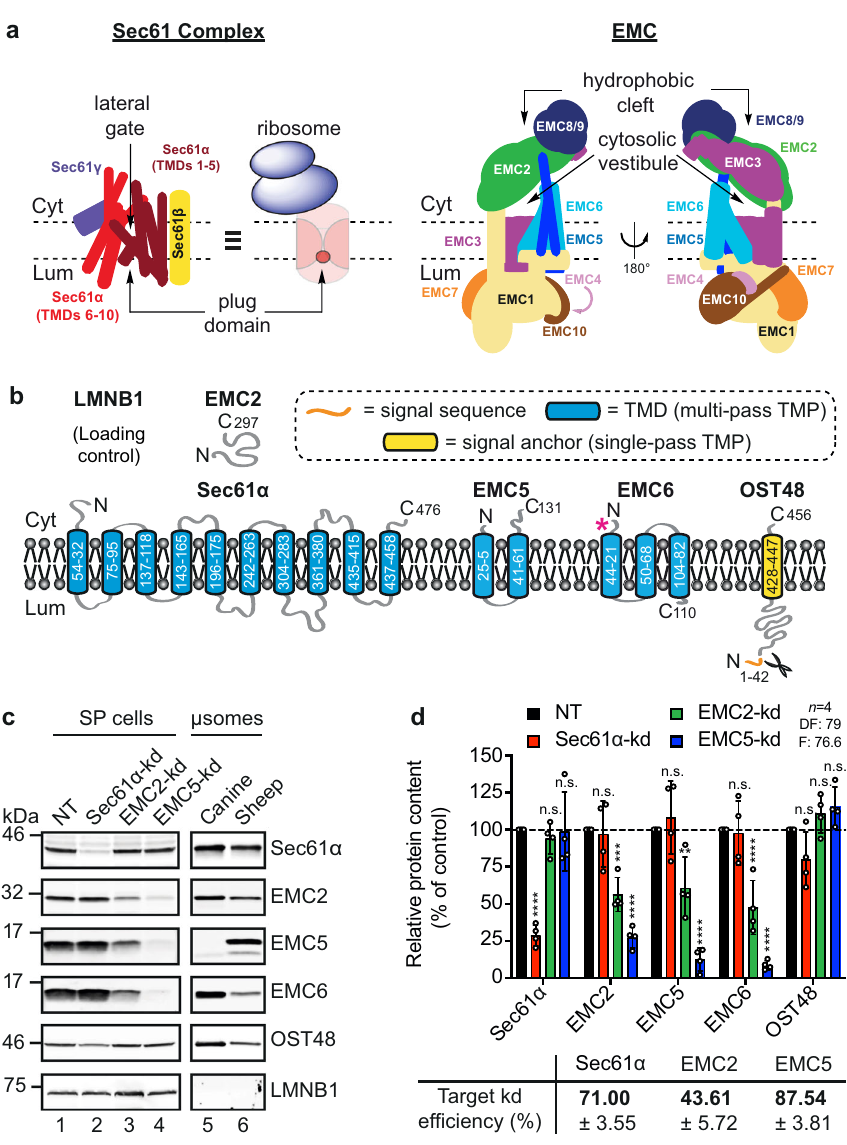
Fig. 2 siRNA-mediated knock-down of Sec61 α , EMC2 and EMC5. a Schematics of the Sec61 complex and the EMC. The heterotrimeric Sec61 complex ( α , β , γ subunits) forms a protein-conducting aqueous channel through which polypeptides are translocated into and across the ER membrane. Its actions are regulated via a plug domain and lateral gate 31,32 . The EMC is organised into a basket-shaped cytosolic domain (EMC2, EMC8/9), a transmembrane- spanning region (EMC3, EMC5, EMC6) and an L-shaped lumenal region (EMC1, EMC4, EMC7, EMC10). The insertase site is formed by EMC3/EMC6 near the cytosolic vestibule, whilst the hydrophobic cleft may have a role in client transmembrane domain capture 11 – 14 . b Outlines of targets for siRNA-mediated knock-down: Sec61 α , EMC2, EMC5, together with additional proteins EMC6 and OST48 (48 kDa subunit of the oligosaccharyl-transferase complex) analysed by immunoblotting are shown. LMNB1, (Lamin-B1) was used as a loading control for the quantity of SP cells used in each experiment. TMD, transmembrane domain; TMP, transmembrane protein. c The effects of transfecting HeLa cells with non-targeting (NT; lane 1), Sec61 α -targeting (lane 2), EMC2-targeting (lane 3) and EMC5-targeting (lane 4) siRNAs were determined after semi-permeabilisation by immunoblotting for Sec61 α , EMC2, EMC5 and EMC6 subunits, OST48 and LMNB1. ER-derived microsomes ( µ somes) of dog (lane 5) and sheep (lane 6) origin were immunoblotted for the same components. d The ef fi ciencies of siRNA-mediated knock-down (bold) were calculated as a proportion of the signal intensity obtained with the NT control (set as 100%). Bar quanti fi cations are given as means ± SEM for four separate siRNA treatments ( n = 4, biologically independent experiments) with statistical signi fi cance of siRNA-mediated knock-downs (two-way ANOVA, DF and F values shown in the fi gure) determined using Tukey ’ s